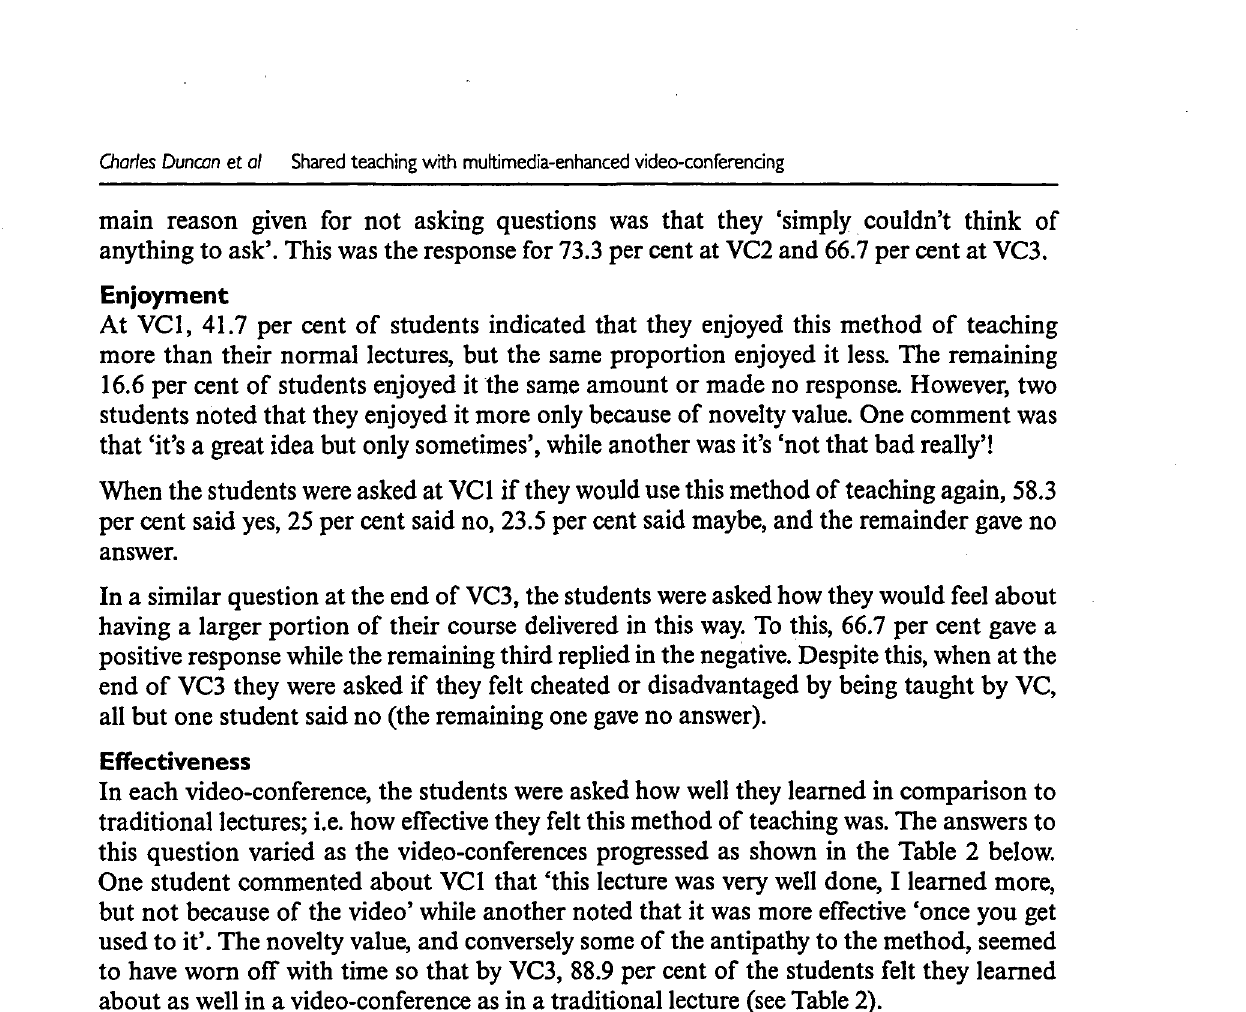
Table 2: Percentages of students commenting on the effectiveness of this teaching method compared to traditional lectures (percentages may not sum to 100 per cent due to